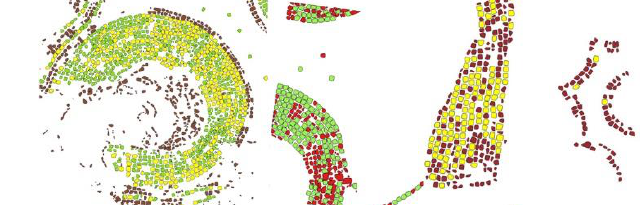
Figure 14 (a) Zone 3 Classification, (b) Zone 2 Classification, (c) Zone 1 Classification